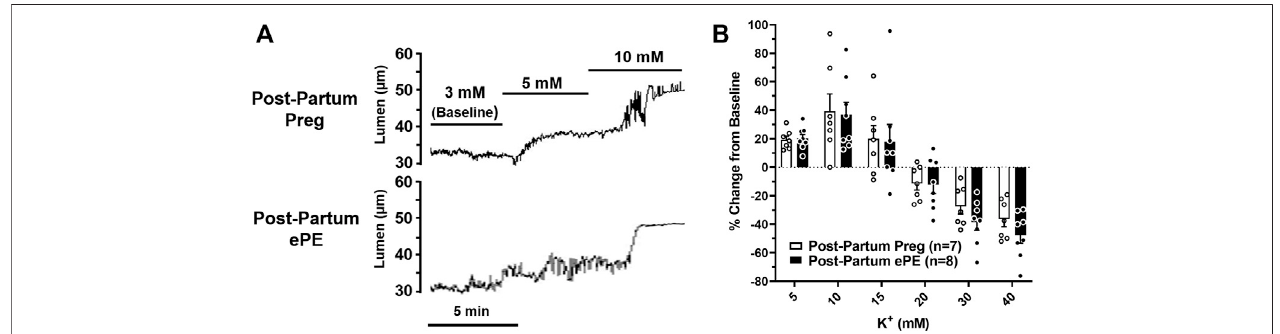
FIGURE4| Reactivity ofhippocampal arterioles (HAs) toincreasedextracellular K + concentrations. (A) Representativelumen diameter tracingofHAsfrom aPost- Partum Preg rat and a Post-Partum ePE rat during exposure to increased extracellular K + concentrations from 3 – 10 mM. (B) Percent change in diameter from baseline (3 mM K + ) was similar between groups at all concentrations of extracellular K + investigated. Data are mean ± SEM.